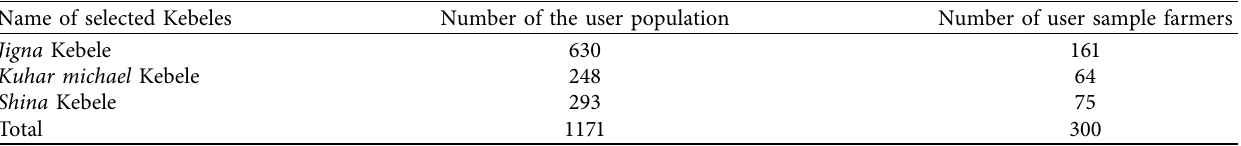
Table 1: Sample size distribution across selected sample